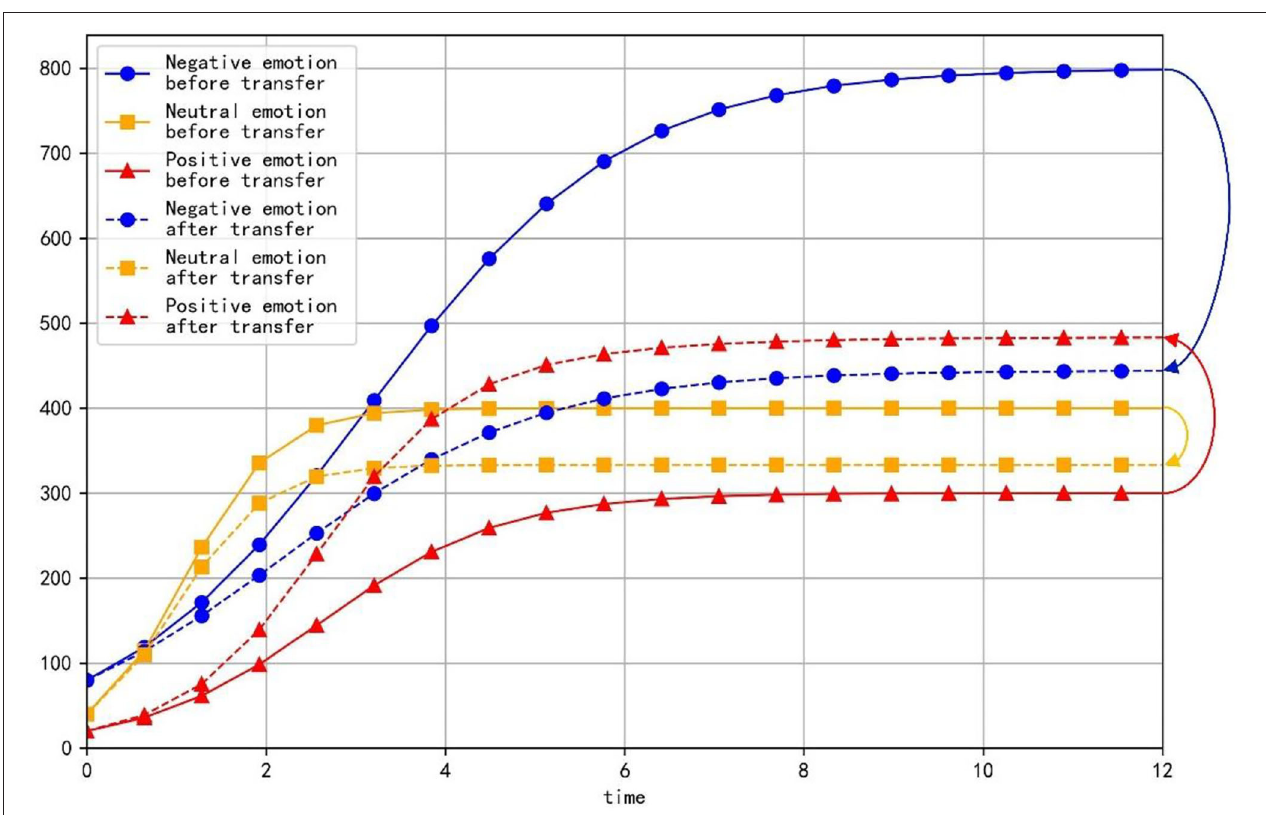
FIGURE 3 | Comparison of emotional information before and after transfer.